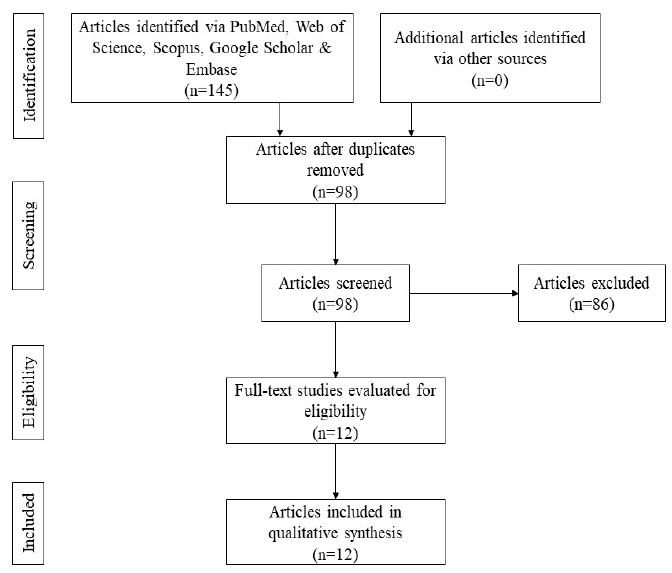
Figure 1. PRISMA flowchart of the article search strategy.